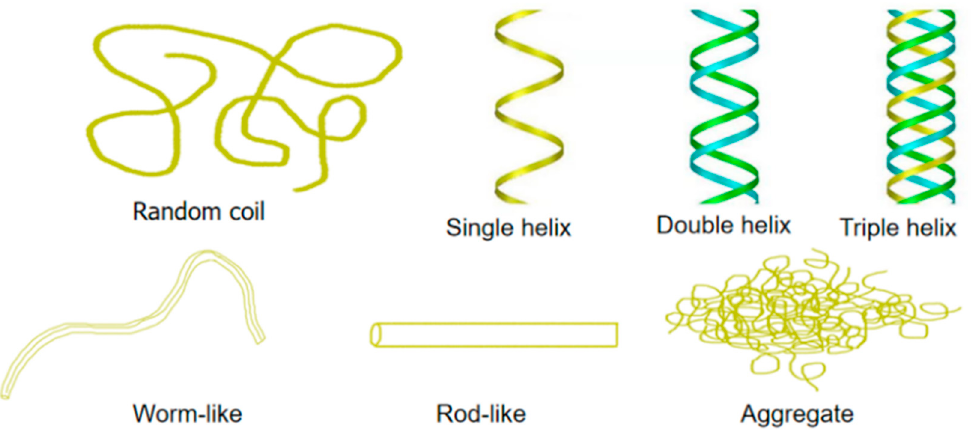
Figure 3. Possible conformations of polysaccharides in aqueous solution.